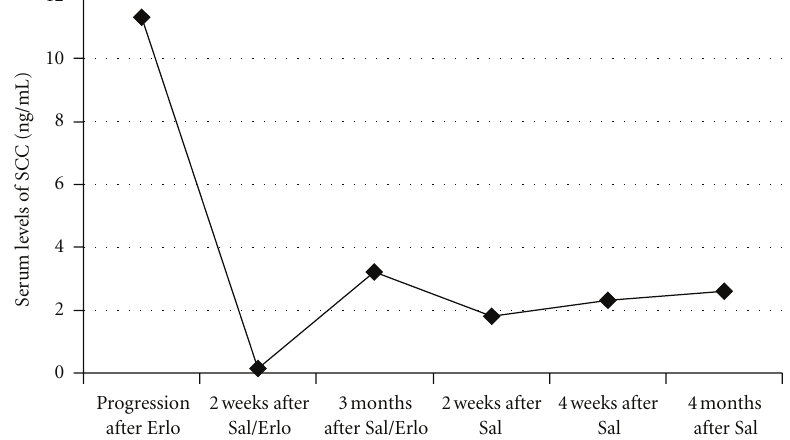
Figure 4: Serum levels of the tumor marker SCC (squamous cell carcinoma antigen) determined in an 82-year-old female patient with advanced vulvar carcinoma (see Section 7.2 . Case 2) at various time points: at tumor progression after 150 mg/day erlotinib for 30 days (progression after Erlo); at tumor regression 2 weeks after 14 intravenous administrations of 200 μ g · kg − 1 salinomycin every second day combined with 150 mg erlotinib every day for 30 days (2 weeks after Sal/Erlo); at tumor progression 3 months after 14 intravenous administrations of 200 μ g · kg − 1 salinomycin every second day combined with 150 mg erlotinib every day for 30 days (3 months after Sal/Erlo); at stable disease 2 weeks, 4 weeks, and 4 months after 12 intravenous administrations of 250 μ g · kg − 1 salinomycin every second day, without addition of erlotinib (2 weeks, 4 weeks, and 4 months after Sal). Adapted from